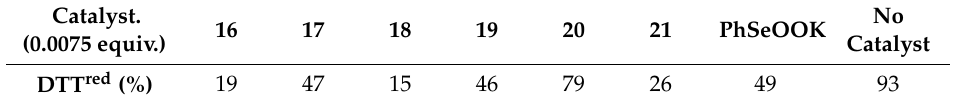
Table 3. Results of the antioxidant activity measurement performed in D 2 O – 0.0075 eq. of Se-catalyst.